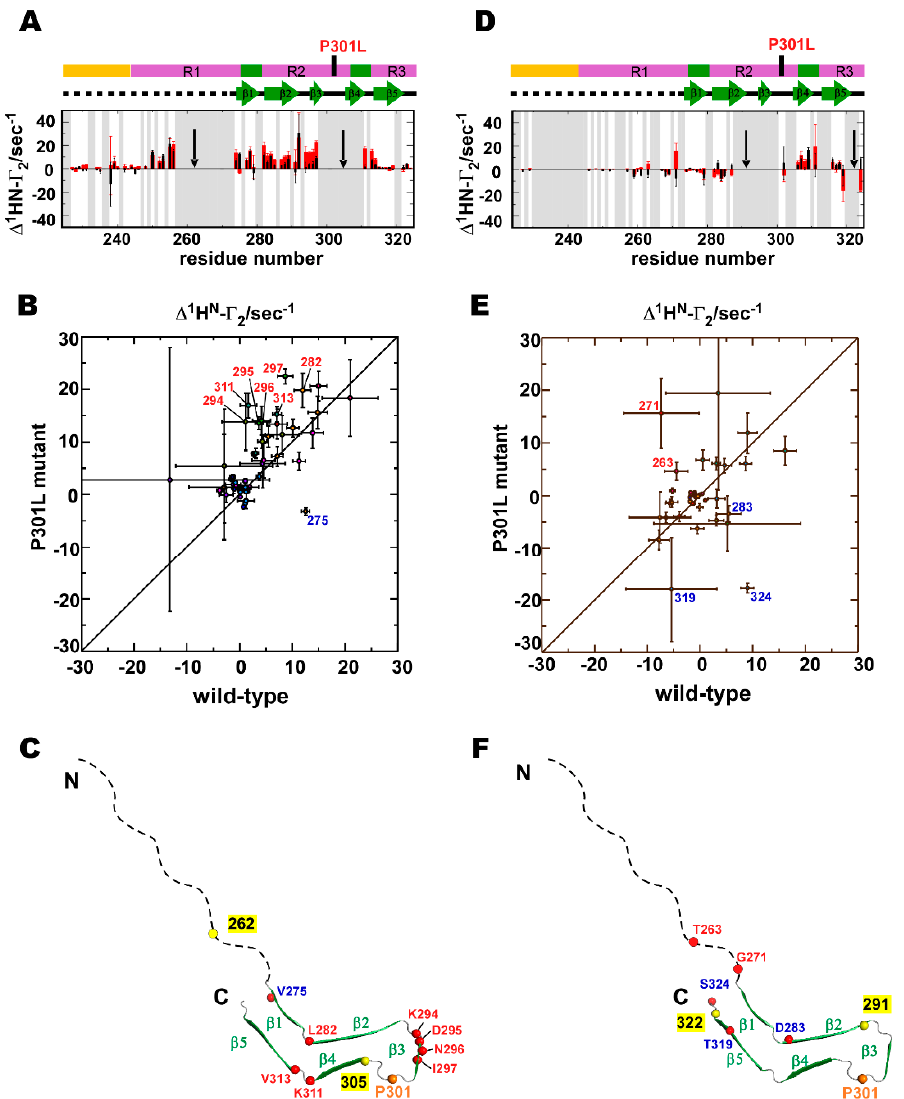
Figure 6. Comparison of PRI rates ( Δ 1 H N - Γ 2 ) between the wild-type and P301L mutant TauF4 Δ . ( A ) PRI rates for the wild-type (black bars) and P301L mutant (red bars) TauF4 Δ labeled at residues 262 and 305. The black arrows indicate the positions of the MTSL labels. ( B ) The correlations of the PRI rates between the wild-type and P31L mutant labeled at 262 and 305 are mapped. Residues showing significant di ff erences in rates between the two proteins are labeled. Labeling in red shows that the PRI rates have increased in the P301L mutant when compared with that of the wild-type, whereas labeling in blue indicates that the PRI rate decreased in the mutant when compared with that of the wild-type protein. ( C ) Residues having significantly changed PRI rates are indicated by the red circles on the heparin-induced tau filament structure (PDB ID: 6QJH) [19]. The colors of the residue numbers represent the same meanings as used in the PRI rate correlations. The yellow circles indicate residues that are MTSL labeled. ( D ) The PRI rates for the wild-type and P301L mutant TauF4 ∆ labeled at residues 291 and 322. ( E ) The PRI rate correlations between the wild-type and the P301L mutant labeled at 291 and 322. ( F ) Residues with significant changes in PRI rates in the P301L mutant are shown. Gray bars represent the residues that did not show the resolved signals on the